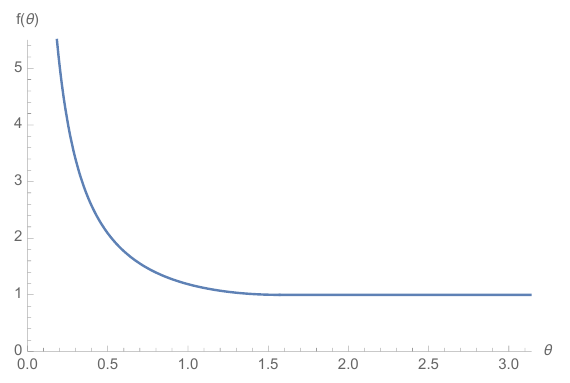
Figure 1 . The function of eq. (3.27) entering the gauge transformation of eqs. (3.25),